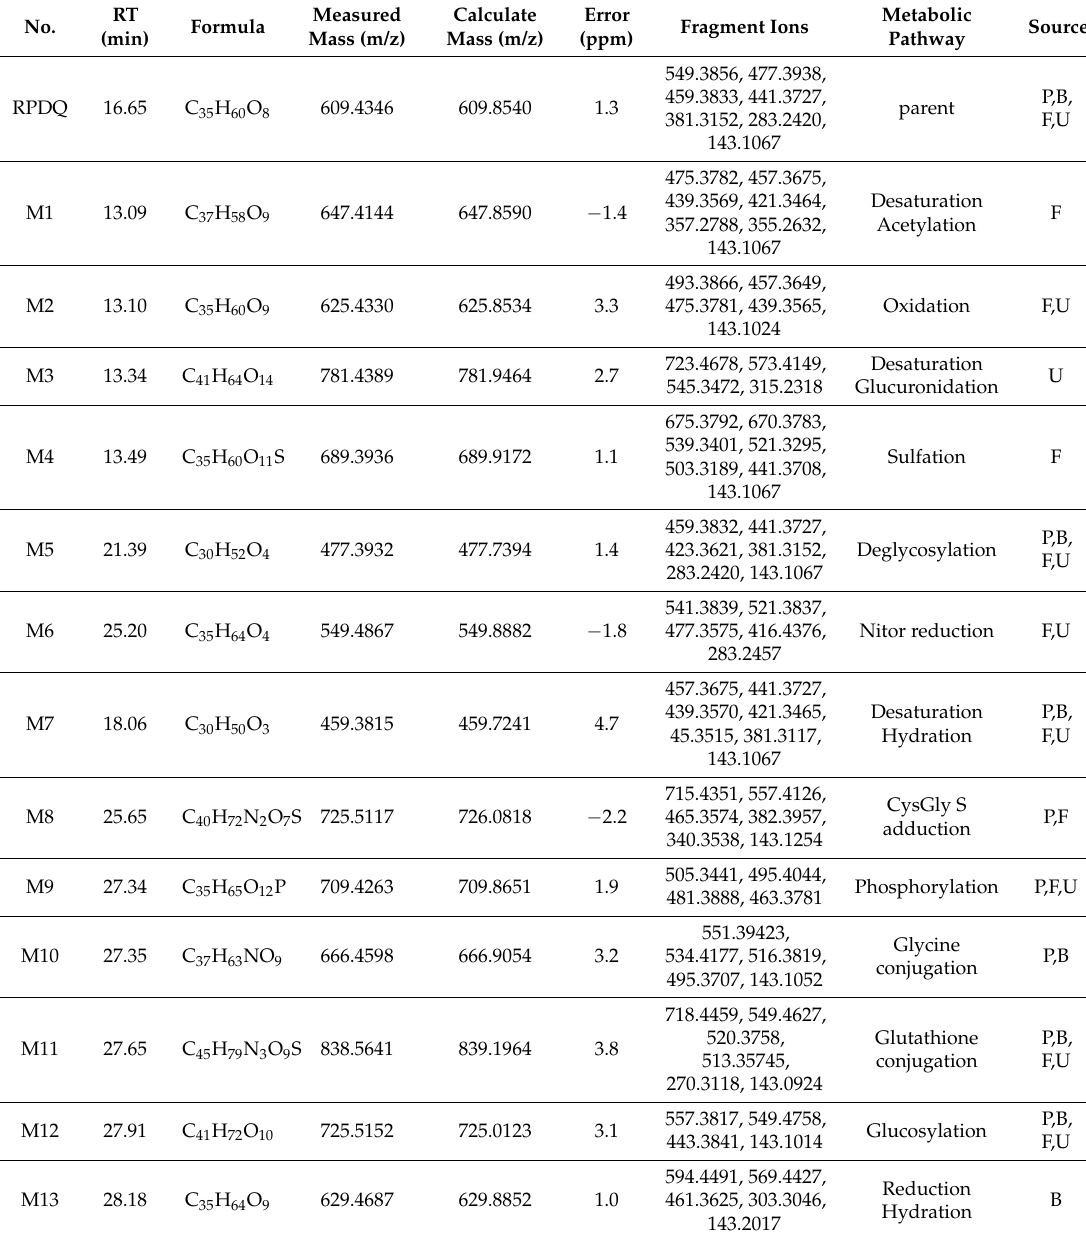
Table 5. Metabolites of RPDQ characterized by using UPLC-Q-TOF-MS E